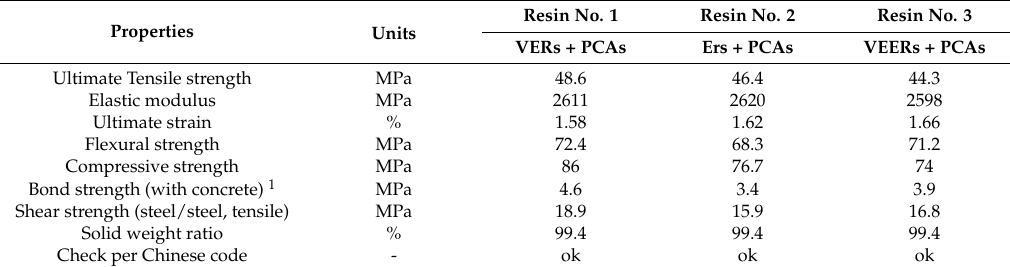
Table 2. Properties of three combined adhesives.